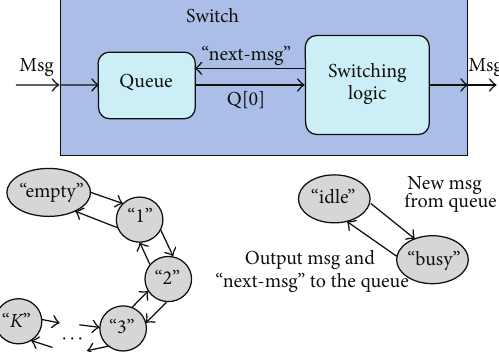
Figure 6: DEVS models of the switch in the proposed NoC example.